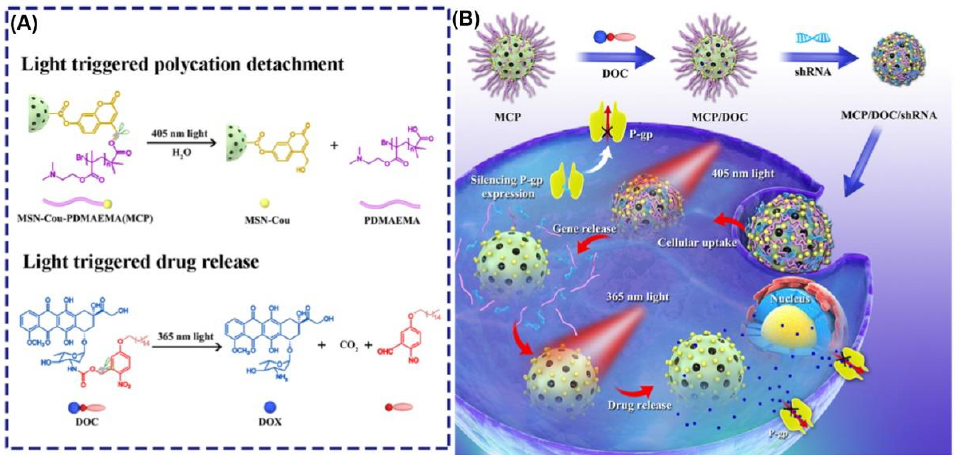
Figure 2. ( A ) Chemical structure and photolysis of photo-responsive vehicle (MCP) and DOX prodrug (DOC). ( B ) Schematic illustration of sequential release of shRNA and DOX regulated by 405 and 365 nm light irradiations, using photo-responsive mesoporous silica nanoparticles as co-delivery vehicles for optimizing the synergistic therapy in multidrug-resistant cancer cells. Reproduced from [34] with permission, copyright 2018, American Chemical Society.